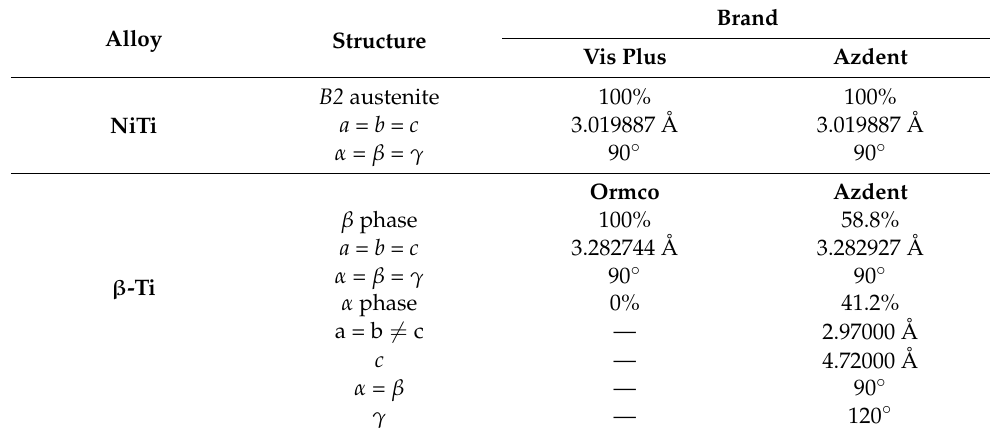
Table 3. Structure refinement results from neutron diffraction data for the samples: weight fractions of the phases and their unit cell parameters.